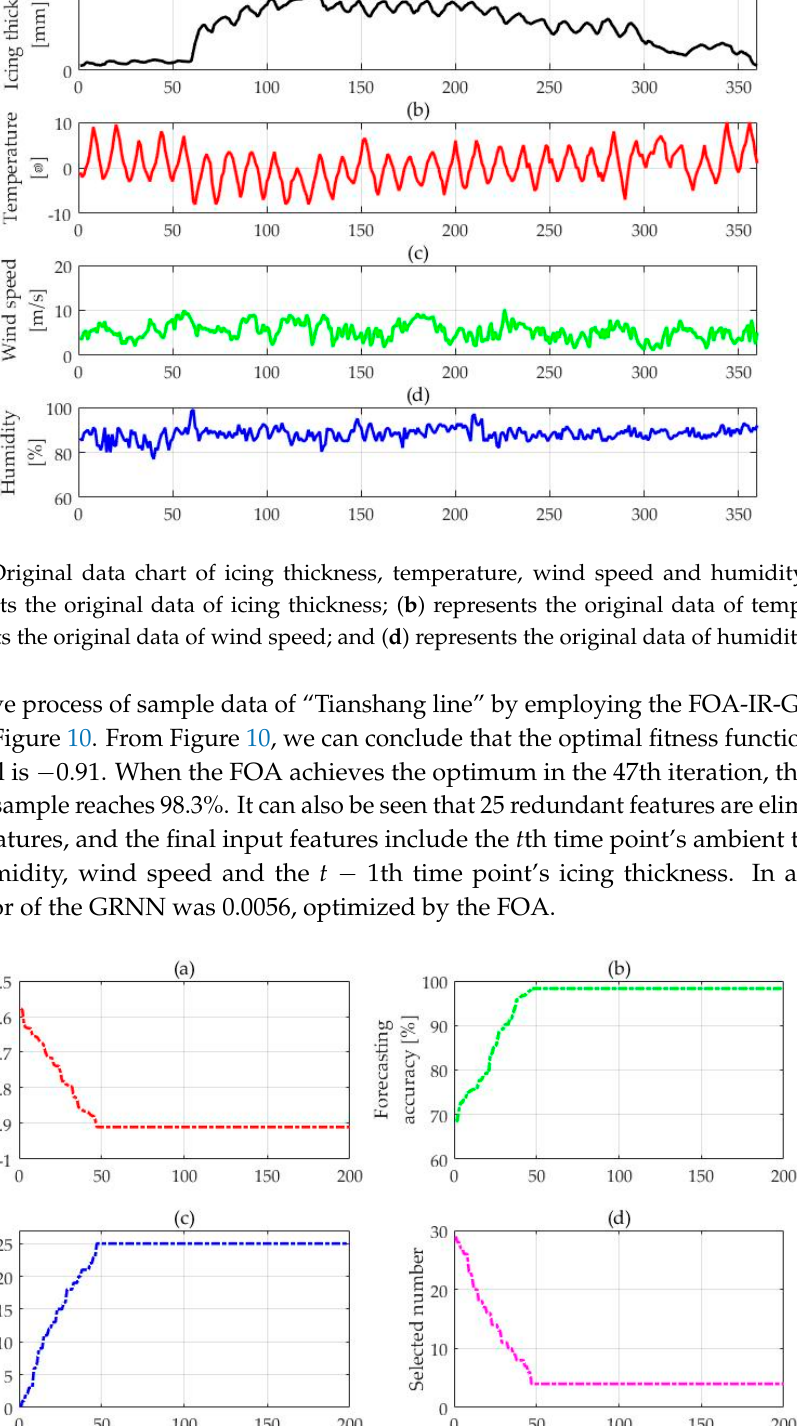
Figure 10. The curve of convergence for feature selection. Note: ( a ) represents the fitness value; ( b ) represents the forecasting accuracy; ( c ) represents the reduced number of candidate feature; and ( d ) represents the selected number of optimization feature.